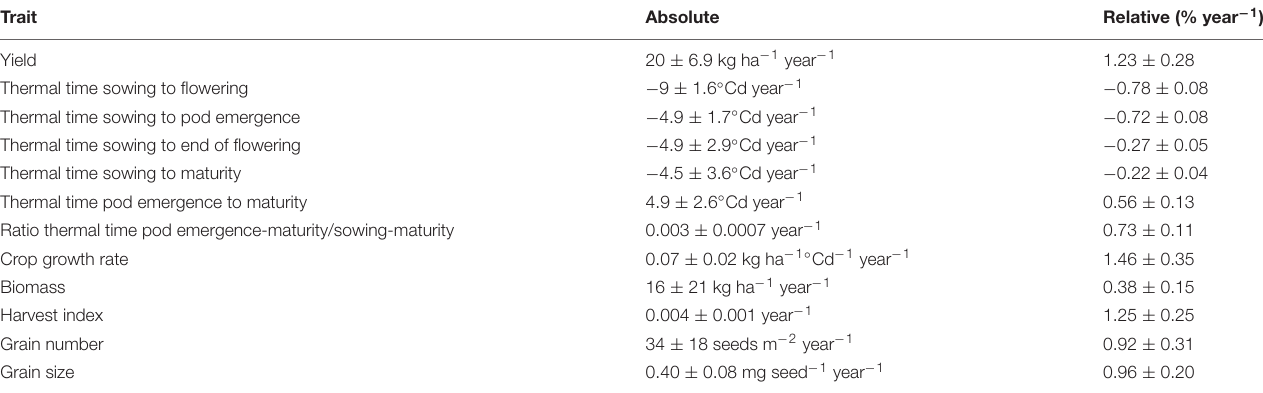
Rates are the slope of least-square regressions between trait and year of release for data pooled across eight environments. Relative rate is percentage of the latest variety.